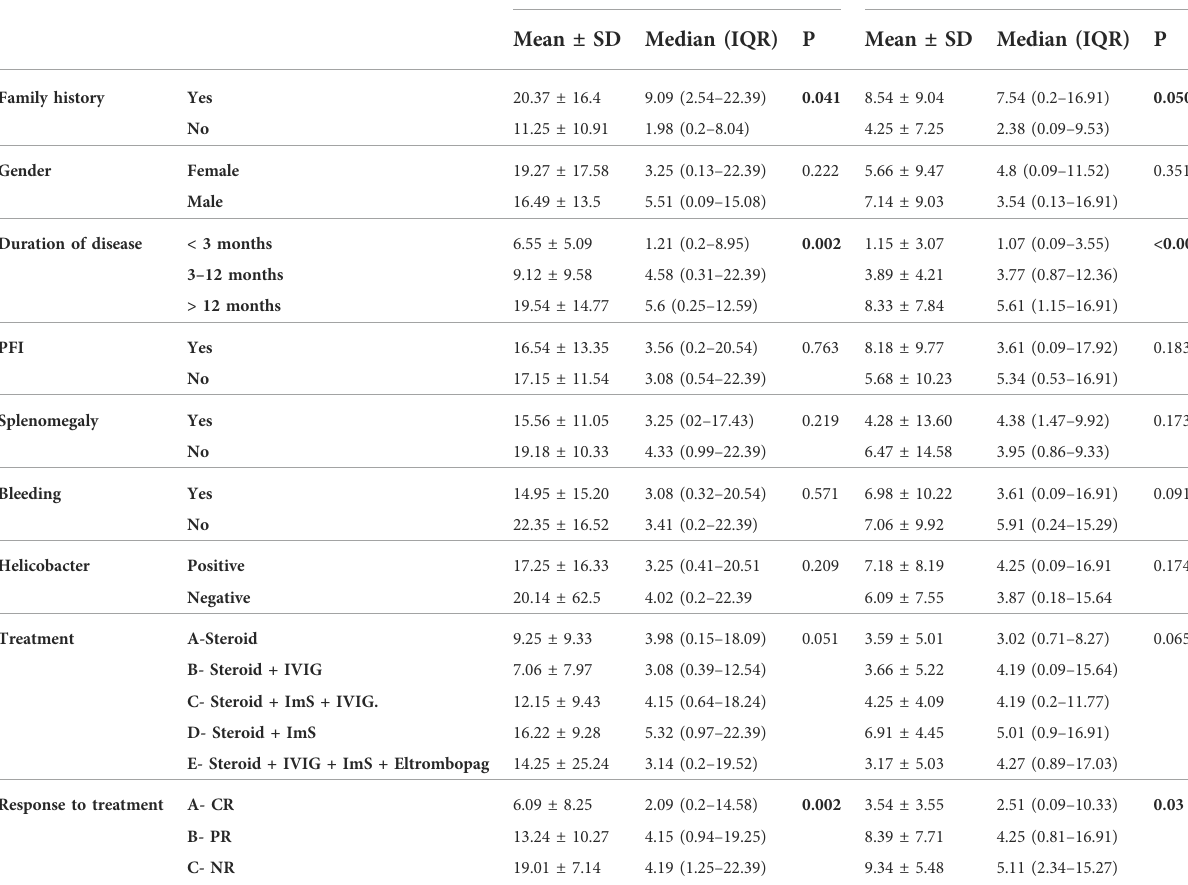
TABLE 3 The association between IFNG-AS1 and GAS5 expressions and the clinical signs, treatment, and response to treatment in the ITP group of patients.